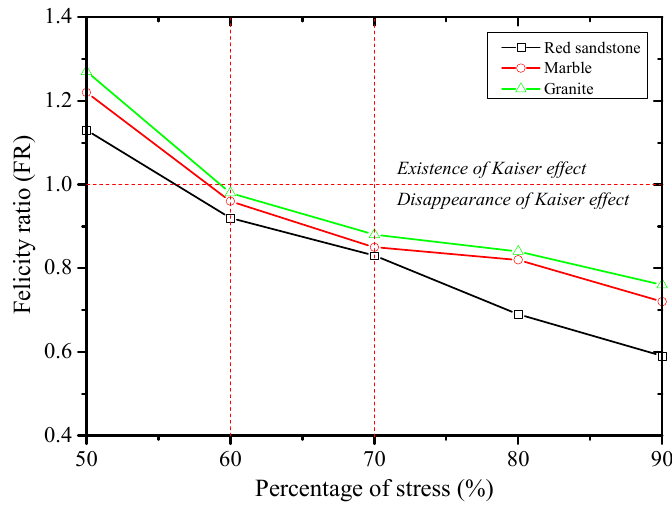
Figure 10. Felicity rate (FR) values of the three types of rocks under different stress level.